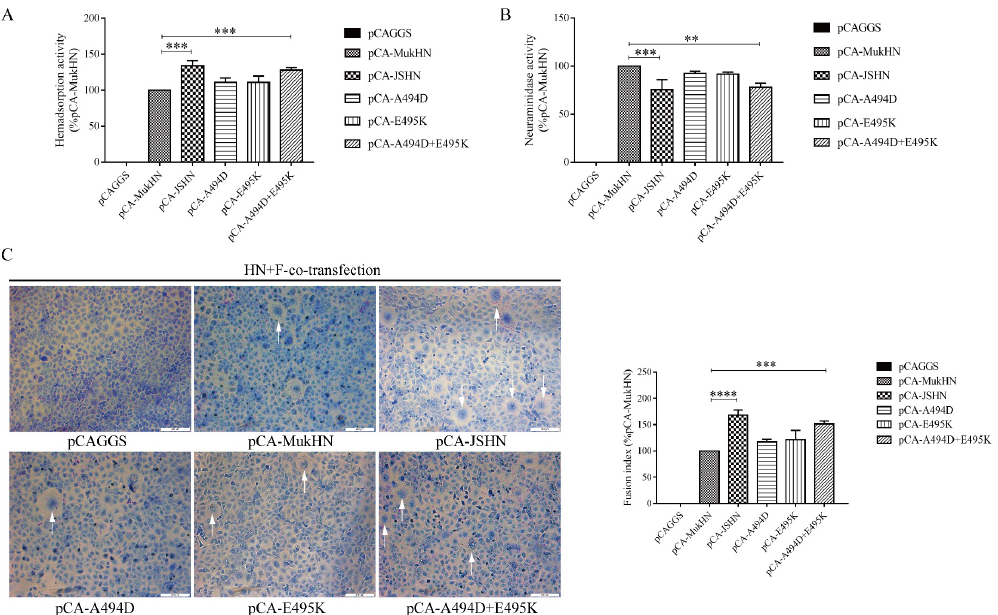
Figure 2. Biological activities of HN proteins at the protein level. HAd ( A ) and NA ( B ) activities were determined after transfection with each HN protein expression plasmid. ( C ) The fusion pro- motion activity of different HN proteins was measured following co-transfection with each HN protein expression plasmid and the F protein plasmid. Images were taken under a microscope at × 200 magnification. The syncytia formation is indicated by white arrows. Bar indicates 200 μ m. All values are normalized to the expression of the values for pCA-MukHN, which was set at 100%. ** p < 0.01, *** p < 0.001, and **** p < 0.0001.